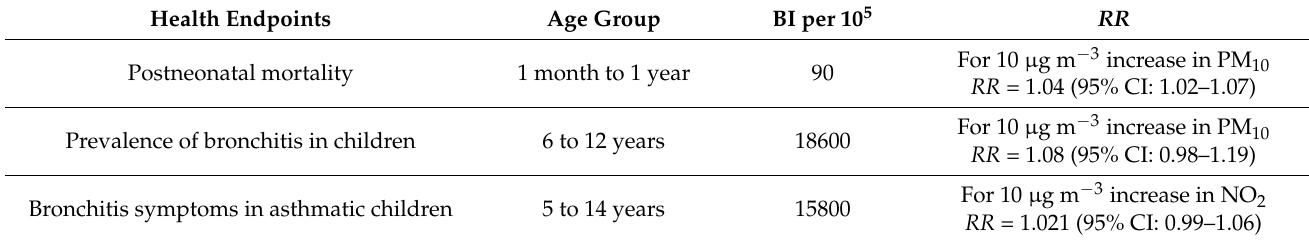
Table 2. Health endpoints, baseline incidences, and RR used in this